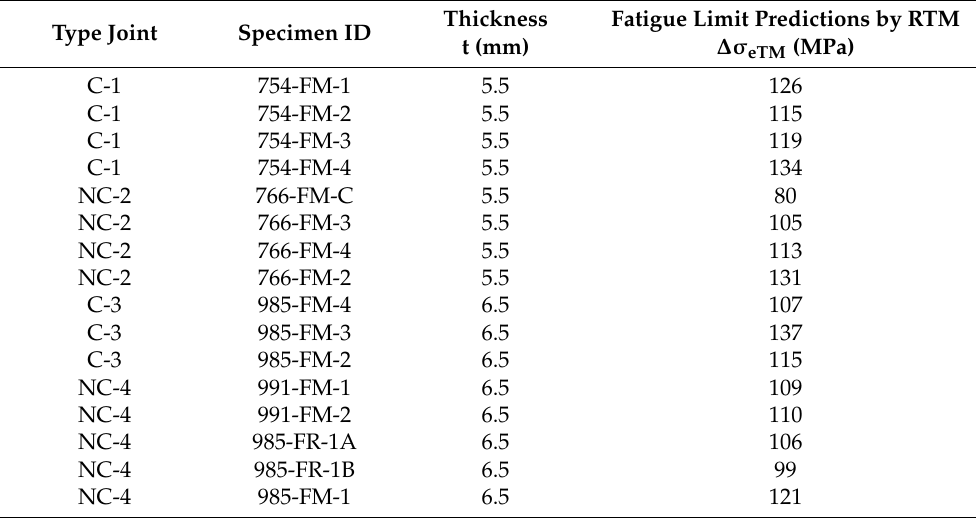
Table 5. Fatigue limits as derived from the rapid thermographic method.